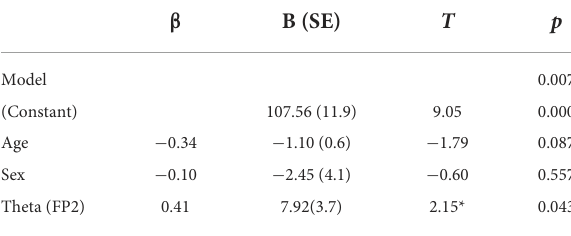
the AQs of OEs for SVA was observed in the frontal (Fz: r = − 0.59, p = 0.002; FP1: r = − 0.55, p = 0.004; F8: r = − 0.41, p